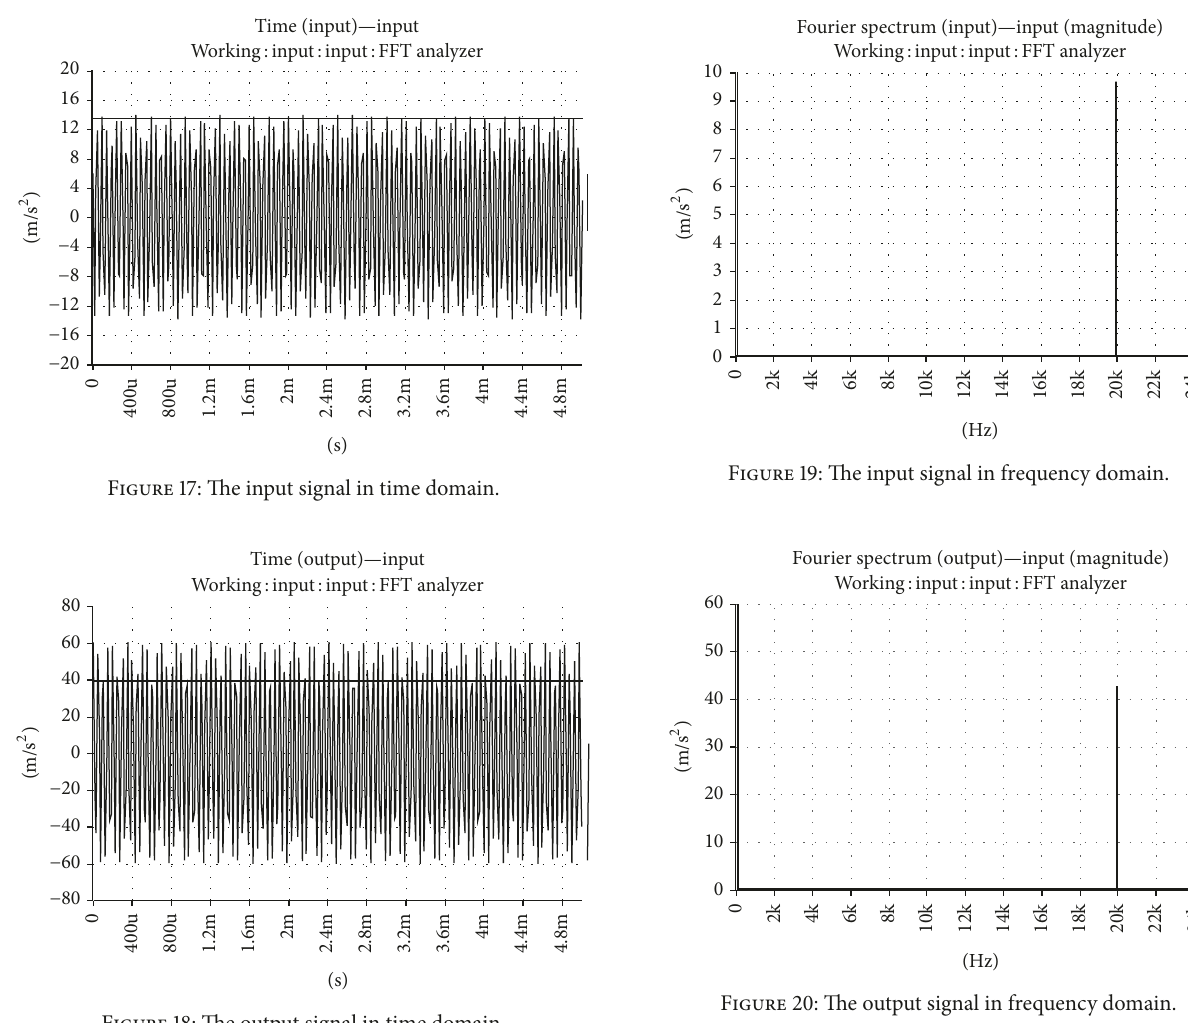
Figure 18: The output signal in time domain.